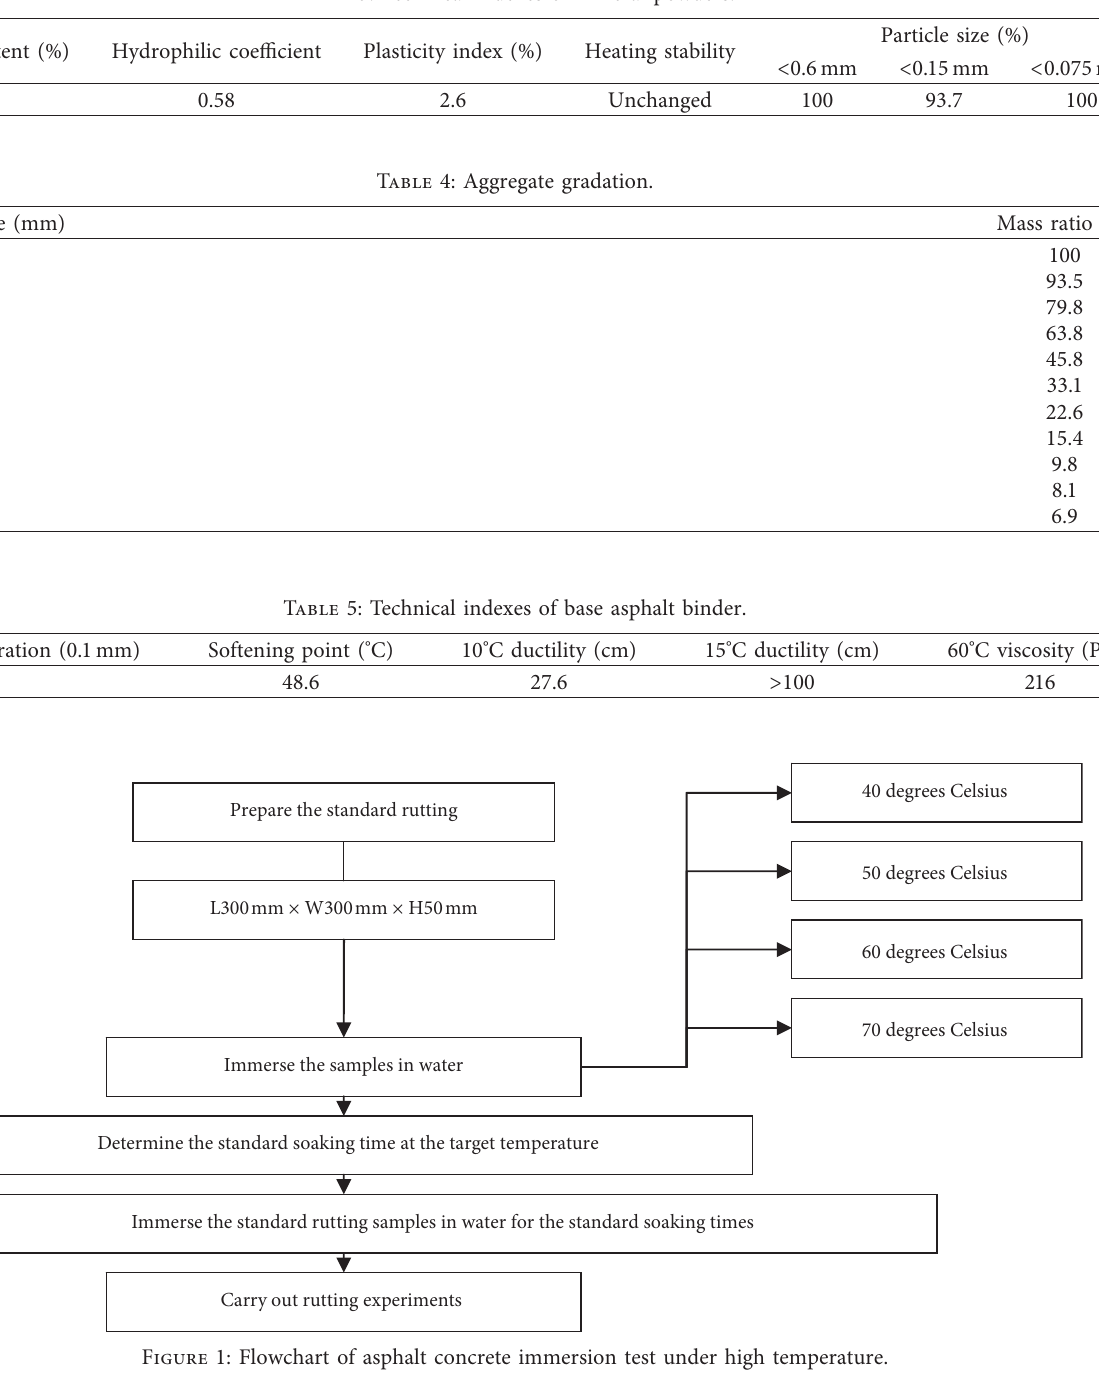
Table 3: Technical indexes of mineral powders.